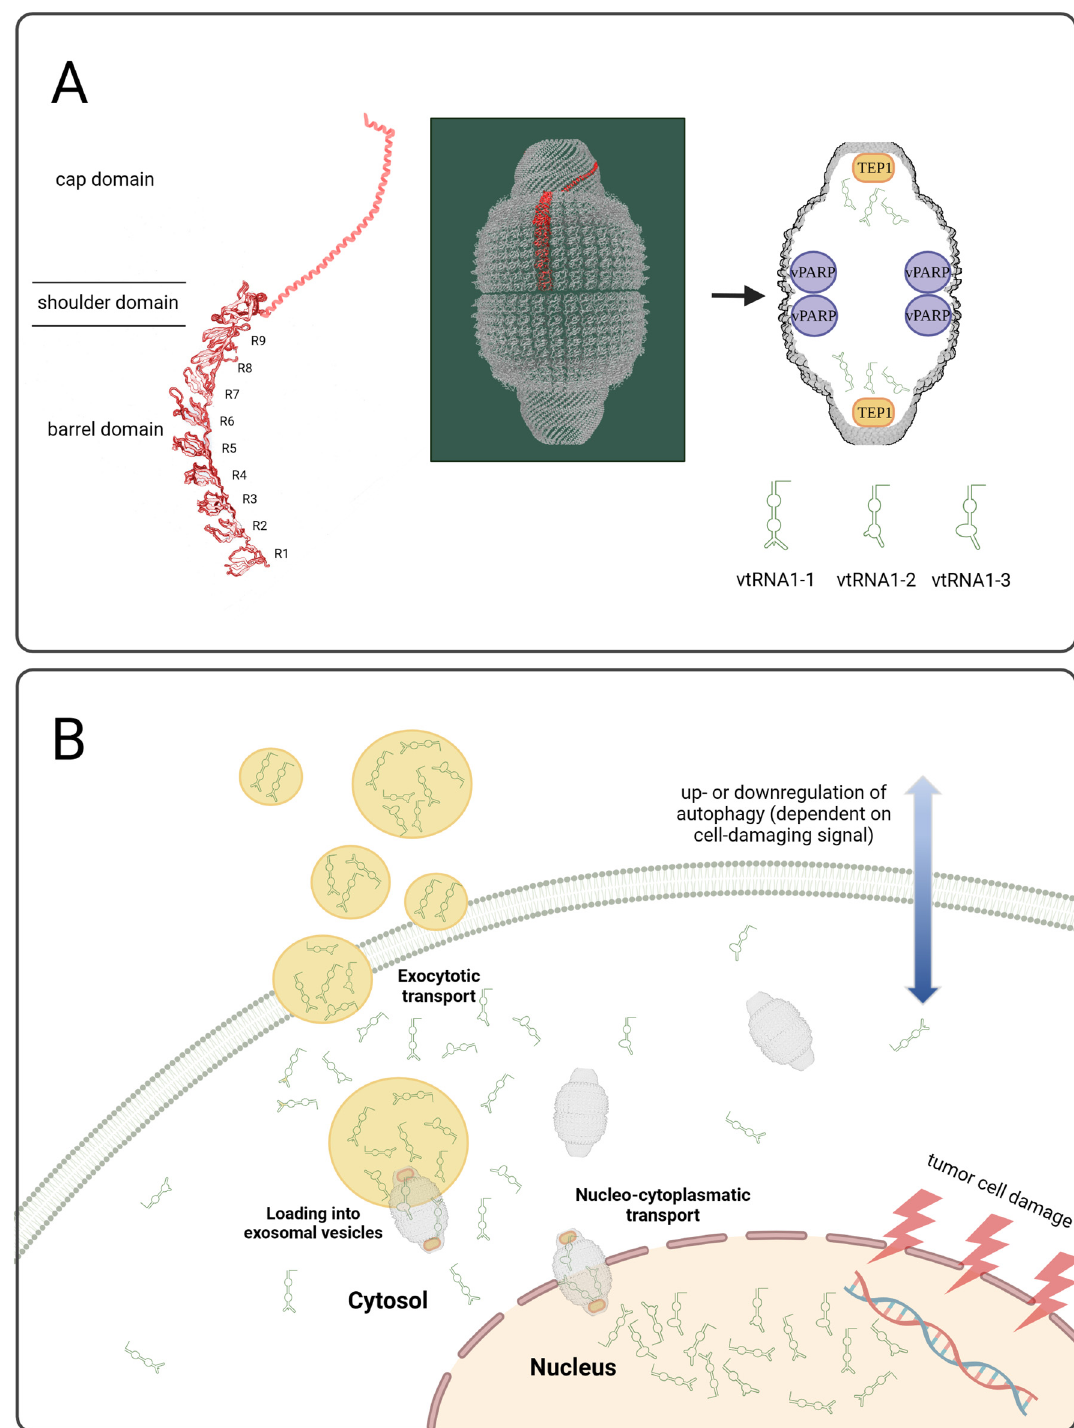
Figure 1: Created with BioRender.com. A) The vault complex and relevant protein and RNA Figure 1. Created with BioRender.com. ( A ) The vault complex and relevant protein and RNA components. MVP structures were adapted from [14,15]. B) Schematic presentation of exosomal components. MVP structures were adapted from [14,15]. ( B ) Schematic presentation of exosomal vault RNA relsease upon therapeutic tumor cell damage. vault RNA relsease upon therapeutic tumor cell